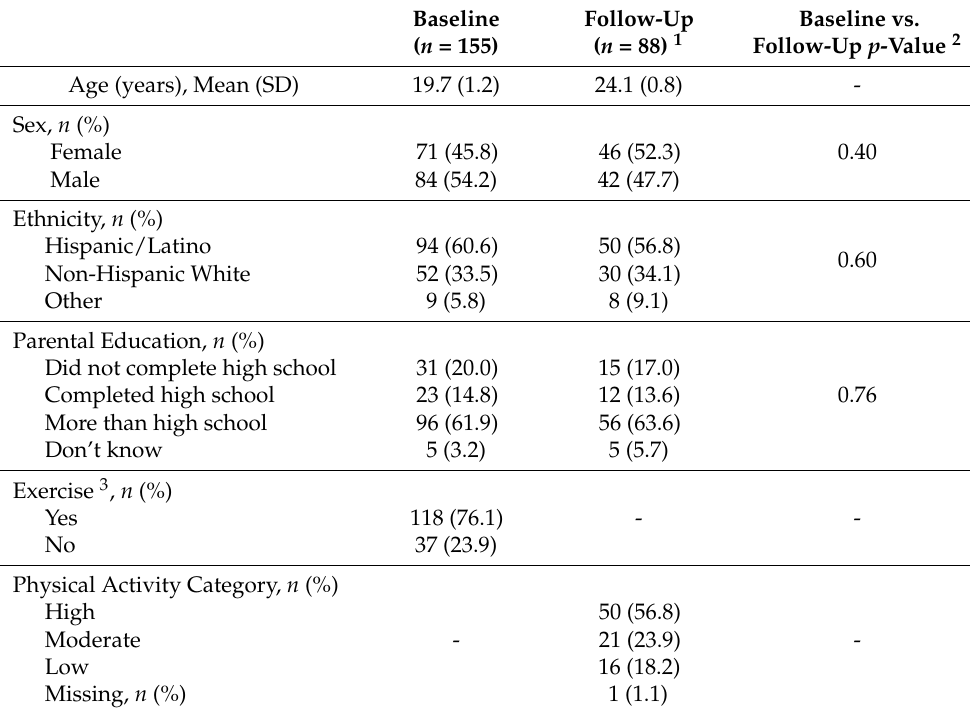
Table 1. Descriptive statistics for participant demographics at baseline and follow-up.